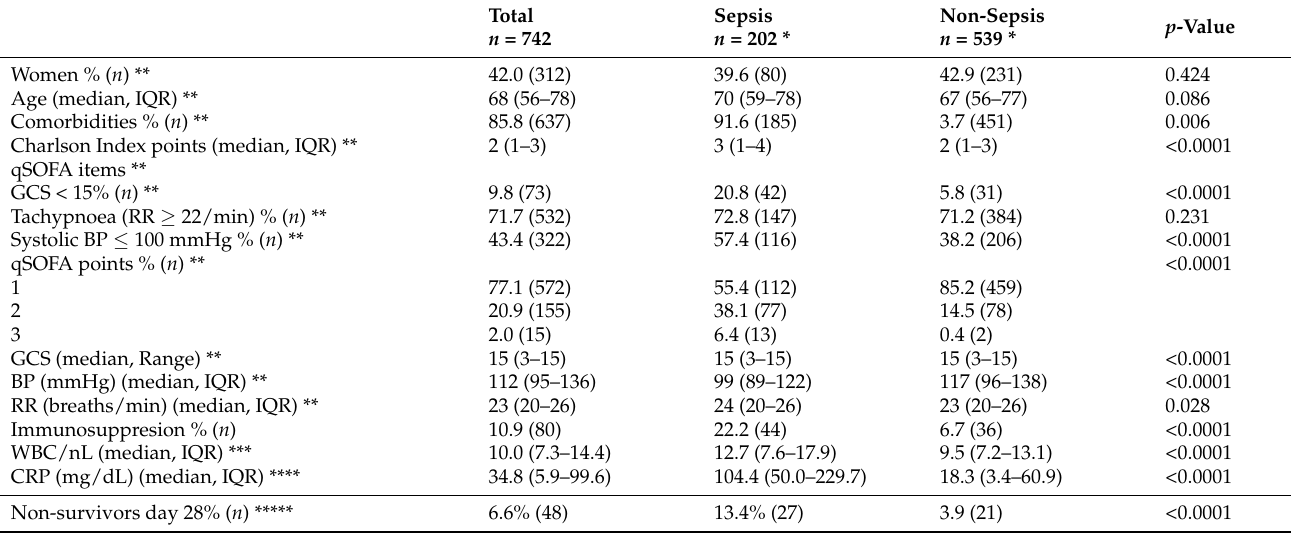
Table 1. Demographic and clinical characteristics the Charlson Comorbidity Index and qSOFA at